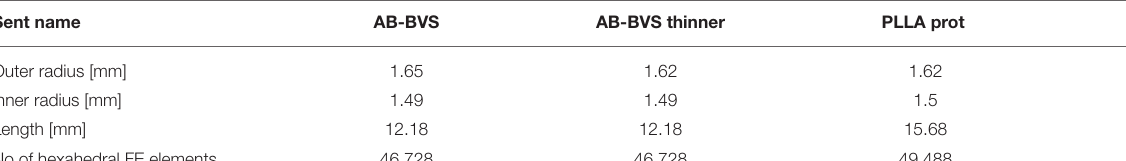
TABLE 1 | Characteristics of the stent.